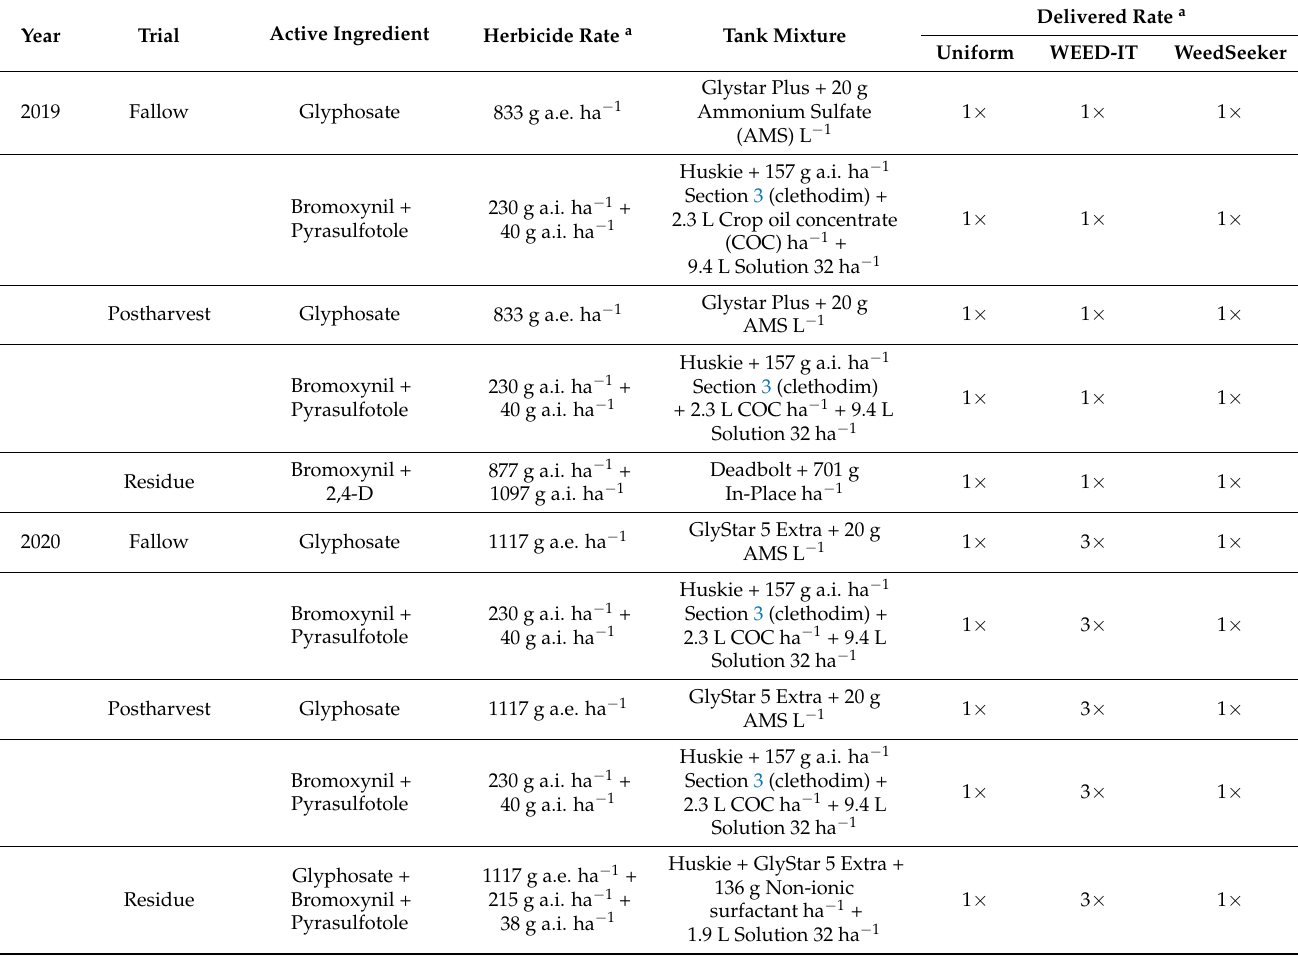
Table 1. Herbicide tank mixtures and herbicide rates for fallow, postharvest, and residue trials in 2019 and